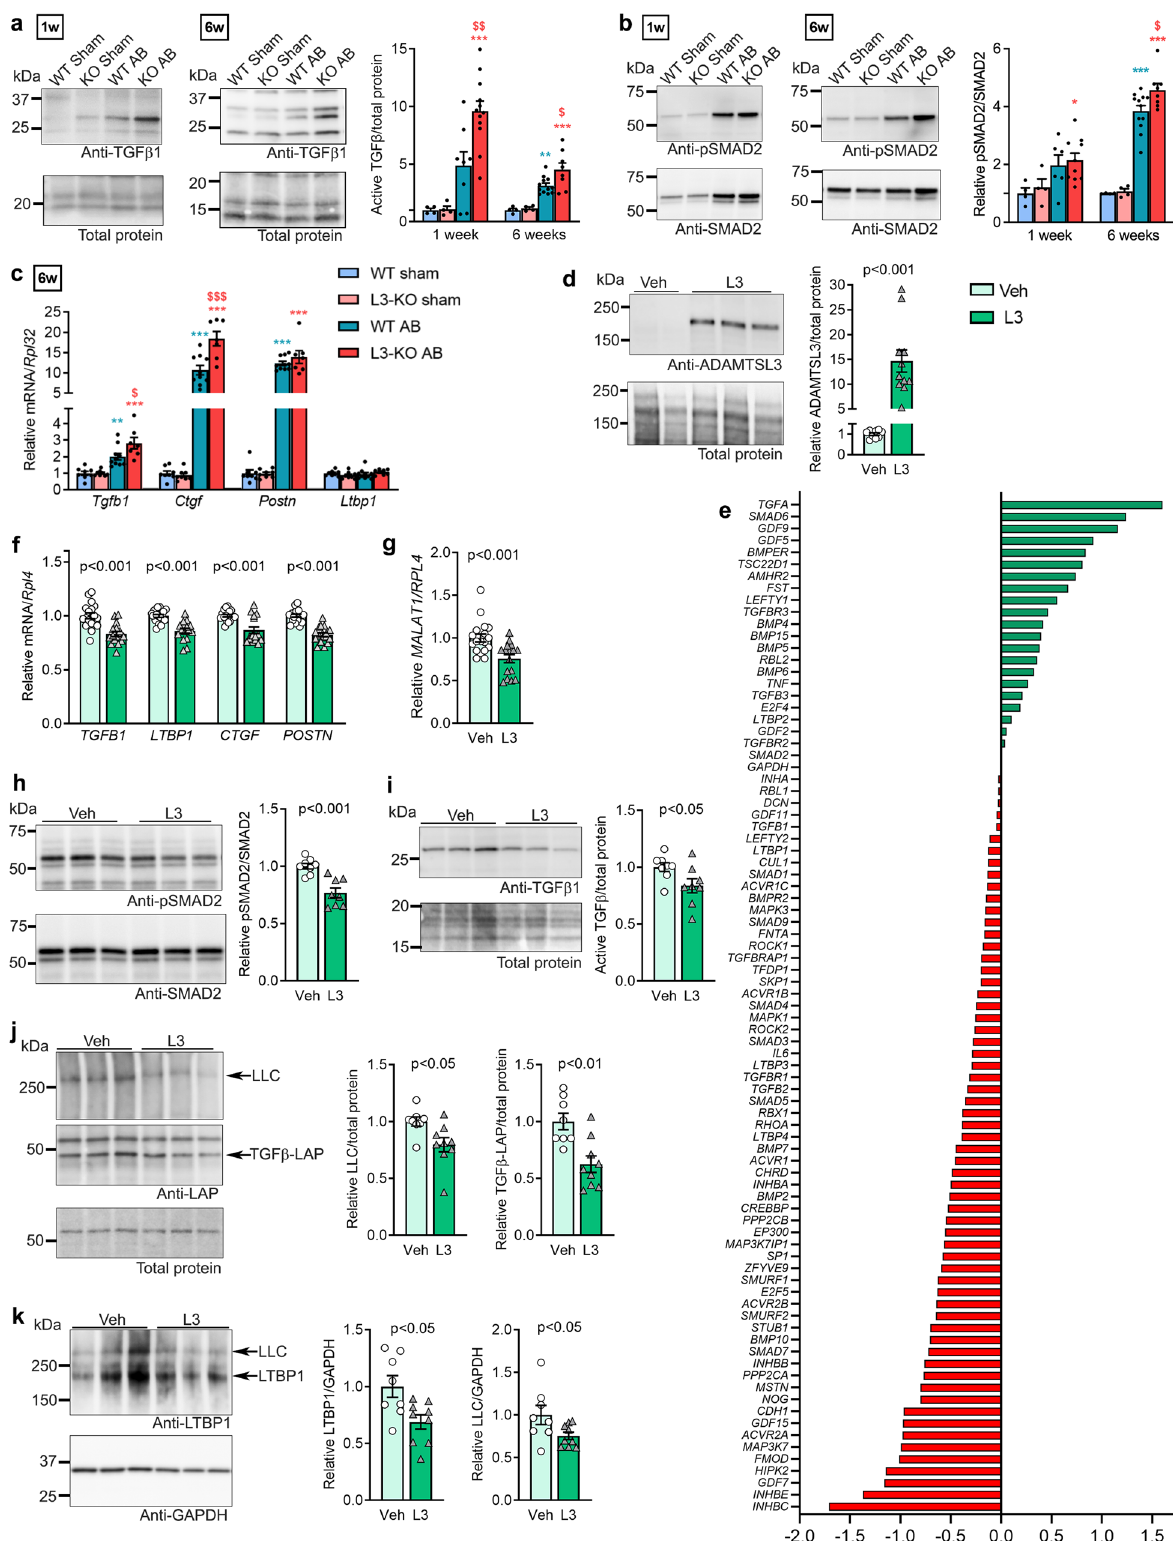
measured by echocardiography and MRI, were not affected by Adamtsl3 inactivation, hearts from non-stressed L3-KO mice had increased weight. This indicates that interpretation of the post-AB cardiac phenotype should be done with caution, as the L3-KO hearts may be pre-disposed to exacerbated disease in response to a